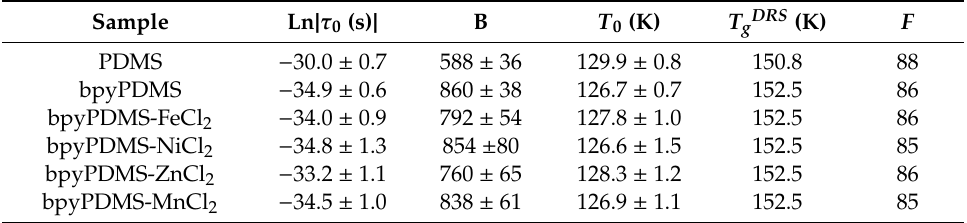
Table 4. VFTH and fragility parameters for the segmental relaxation processes of PDMS, bpyPDMS and metalloorganic complexes determined from dielectric